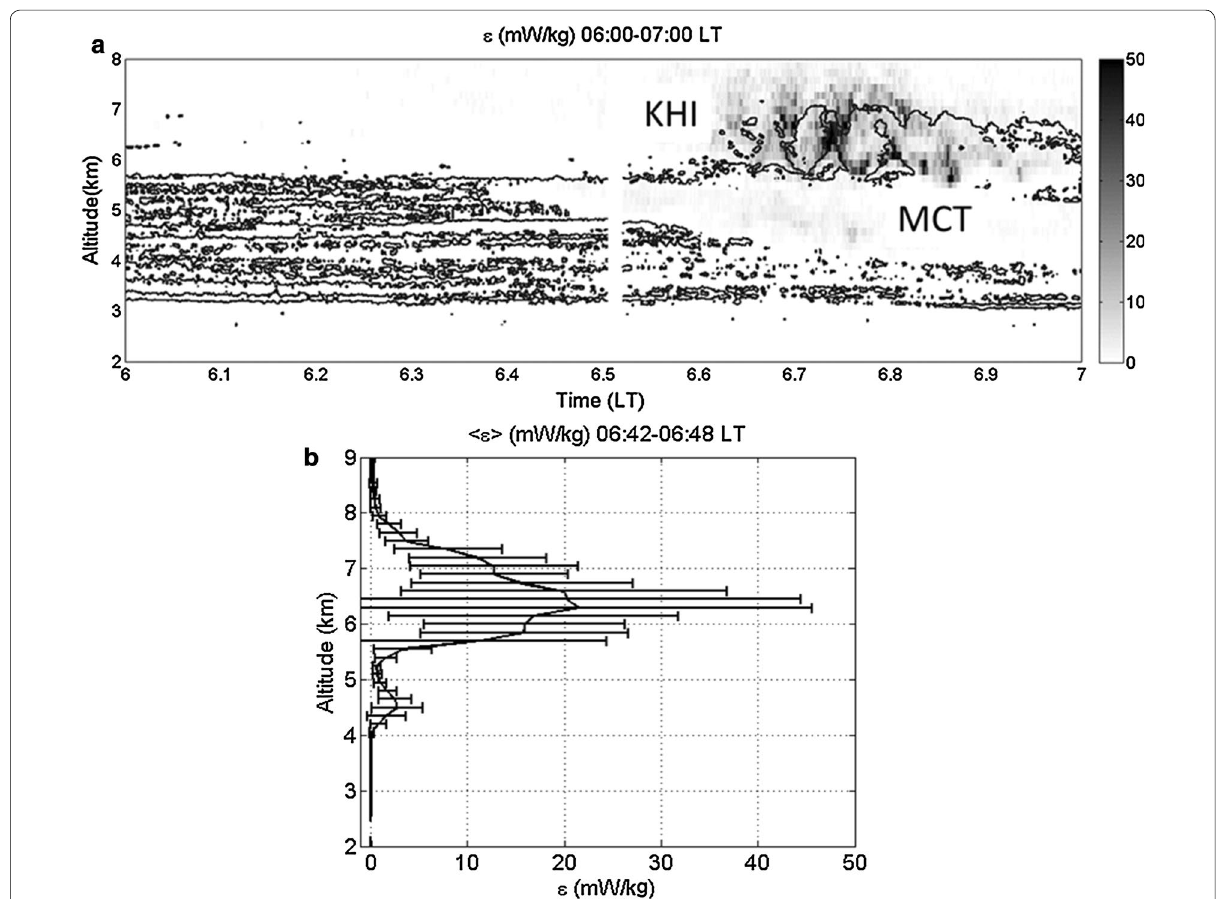
Fig. 9 a Turbulence kinetic energy dissipation rate ε ( mWkg − 1 ) between 0600 LT and 0700 LT. The black contours indicate an arbitrary level of the radar echo power. b Vertical profile of turbulence kinetic energy dissipation rate ε ( mWkg − 1 ) averaged over 6 min from 0642 LT to 0648 LT. The horizontal bars show the time variability ( the standard ±